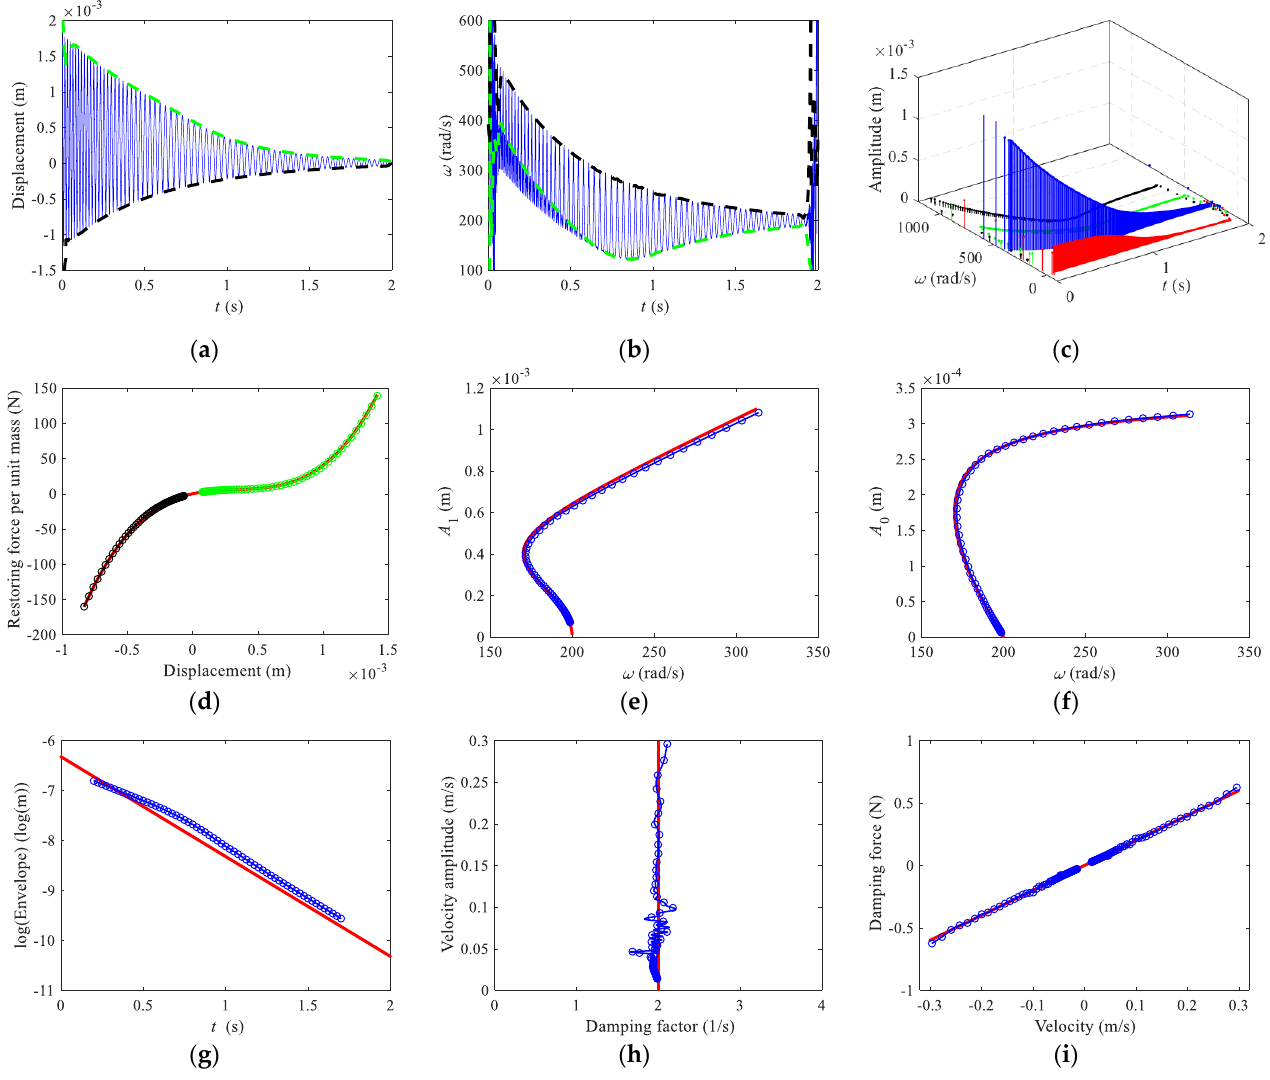
Figure 1. Hilbert transform. ( a ) Time domain response and envelopes, ( b ) frequencies, ( c ) HVD, ( d ) restoring force curve, ( e ) backbone curve of first harmonic term A 1 , ( f ) backbone curve of bias term A 0 , ( g ) logarithmic form of the envelope, ( h ) damping factor, ( i ) damping force curve. In ( a , b ), thin solid lines, time domain response, and instantaneous natural frequency; dashed lines, congruent envelope, and congruent modal frequency. In ( d – i ), solid lines, analytical solutions; lines with circles, numerical results.